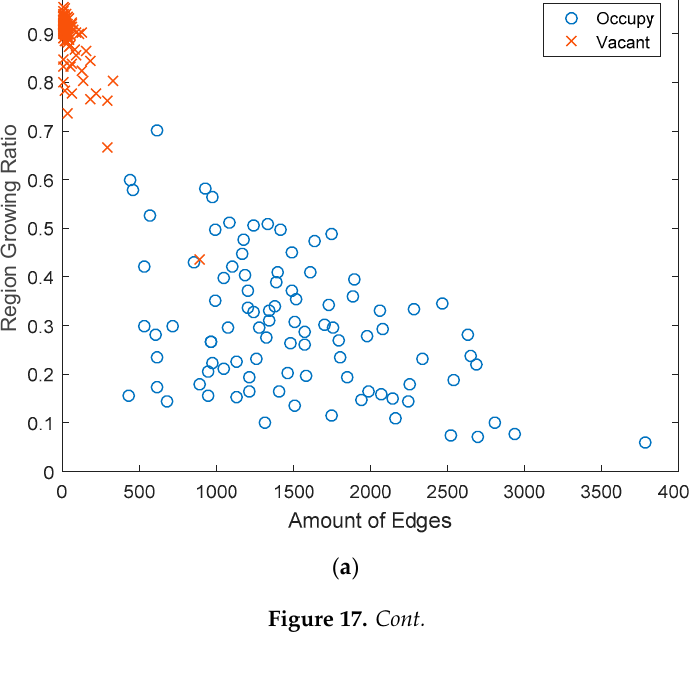
( b ) ( c ) Figure 17. Perpendicular parking training set. ( a ) Scatter plot of features; ( b ) Gaussian distribution of region growing ratio; ( c ) Gaussian distribution of number of edges.